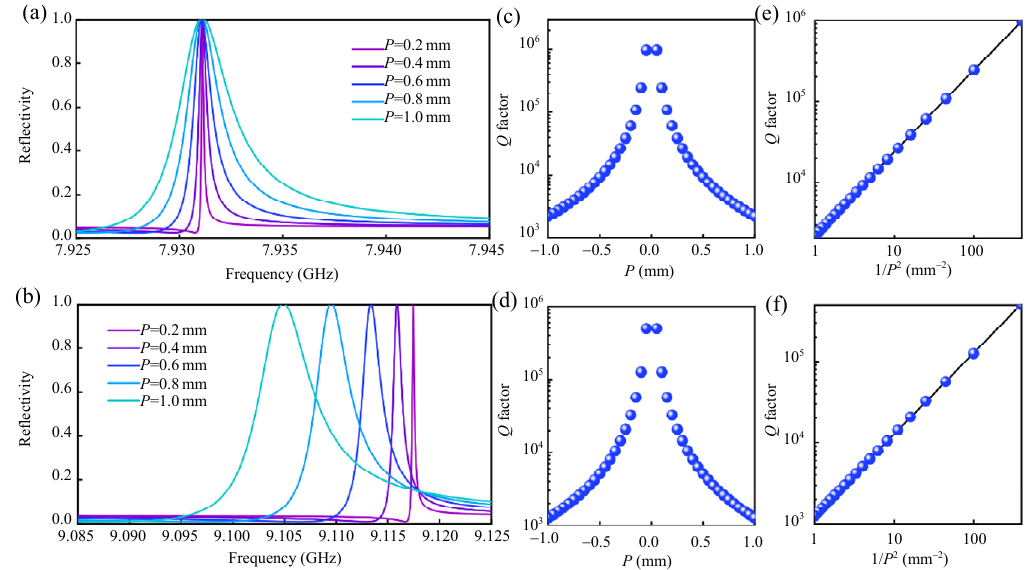
Fig. 5 Reflection spectrum and Q factor when asymmetric parameters change: (a)–(c) Mode 1 and (d)–(f) Mode